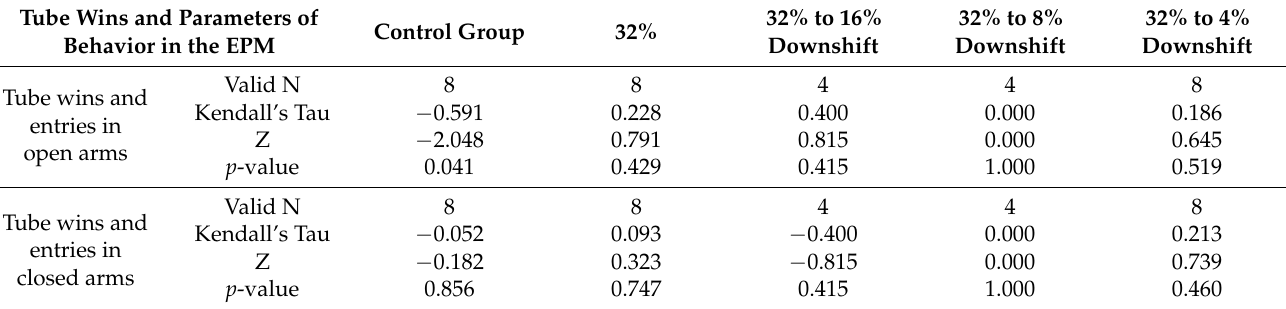
Table 1. Kendall’s tau correlation used to measure the strength of dependence between winning points in a. social confrontation tube test and the parameters of anxiety and general activity obtained in the EPM and NA.